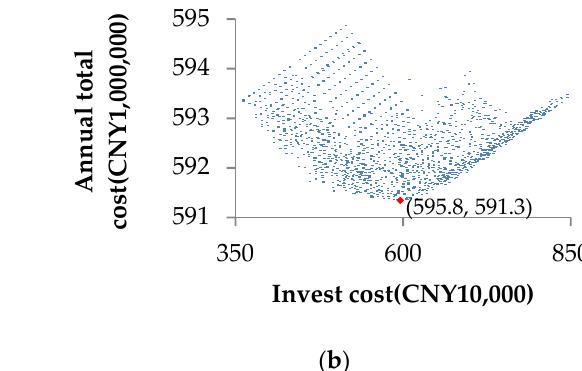
Table 4. Costs of S4, NS4 and S5 configuration schemes.